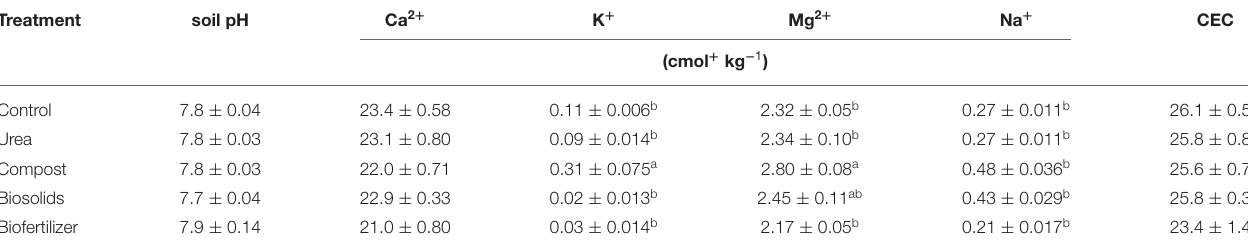
TABLE 2 | Soil pH, extractable nutrients, and cation exchange capacity (CEC) after the sixth crop cycle. Treatment